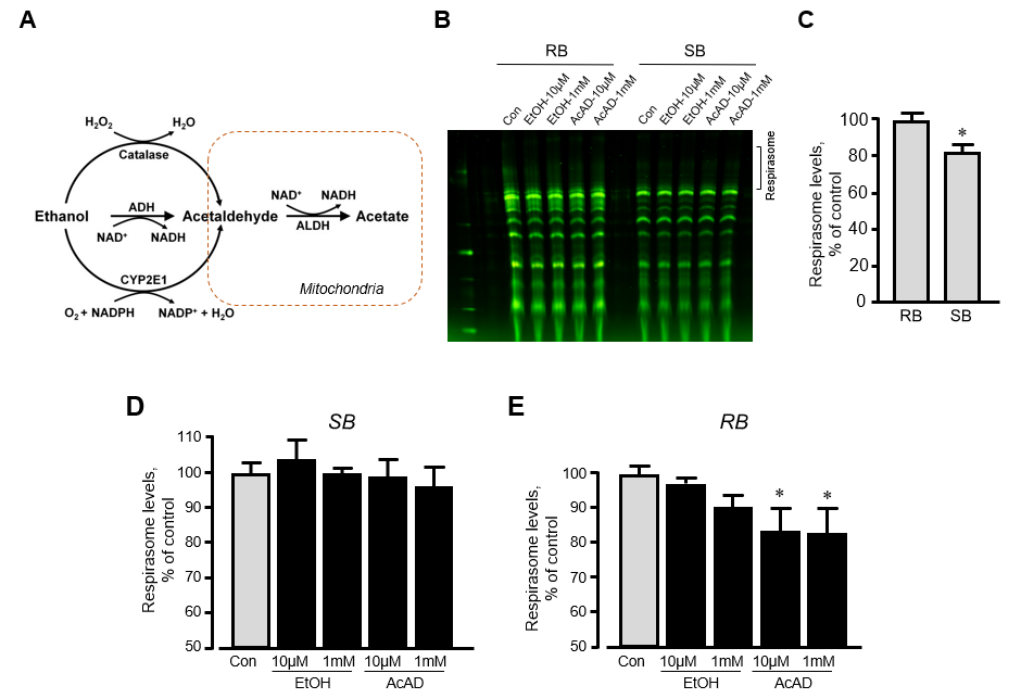
Figure 5. The effects of acetaldehyde (AcAD) and ethanol (EtOH) on the respirasome assembly in mitochondria in vitro . Mitochondria isolated from healthy (non-treated) rat hearts were diluted in either sucrose or respiration buffer and incubated with AcAD or EtOH for 60 min at 37 °C. At the end of the incubation period, RCS were analyzed by BN-PAGE. ( A ) Diagram of EtOH metabolism in the cell. ( B ) Representative images of RCS in mitochondria diluted in either sucrose or respiration buffer. ( C ) Respirasome levels in mitochondria diluted in either sucrose or respiration buffer. ( D,E ) The effects of AcAD and EtOH at high (1 mM) and low (10 µM) concentrations on respirasome levels in mitochondria diluted in either sucrose ( D ) or respiration buffer ( E ). Respirasome levels were presented as the percentage of control (Con). * p < 0 .05 vs. Con, n = 3 per each group. RB: Respiration buffer, SB: Sucrose buffer.